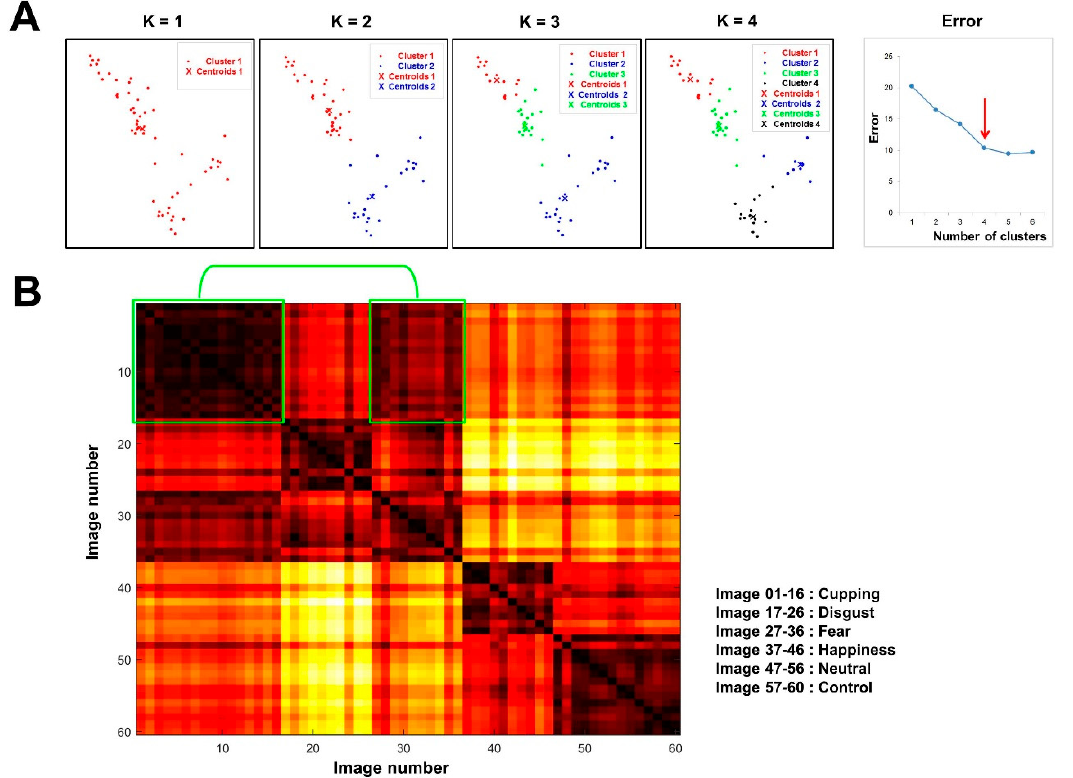
Figure 3. Cluster analysis of visual stimuli. A : Cluster analysis using the K -means clustering method. As K changed from one to six, the errors were 20.23, 16.45, 14.16, 10.37, 9.43, and 9.66, respectively. Setting the number of clusters at four yielded a compact spatial organisation. Most of the cupping therapy images were grouped together with fear images, whereas the control images were grouped together with neutral images. B : The two-dimensional spatial organisation of psychophysical responses to the emotional stimuli. Cupping therapy images were separated from fear images by shorter distances (in the green box), but from happy, neutral, and control images by longer distances. The image pairs separated by small distances are coloured a darker red than those separated by larger distances.